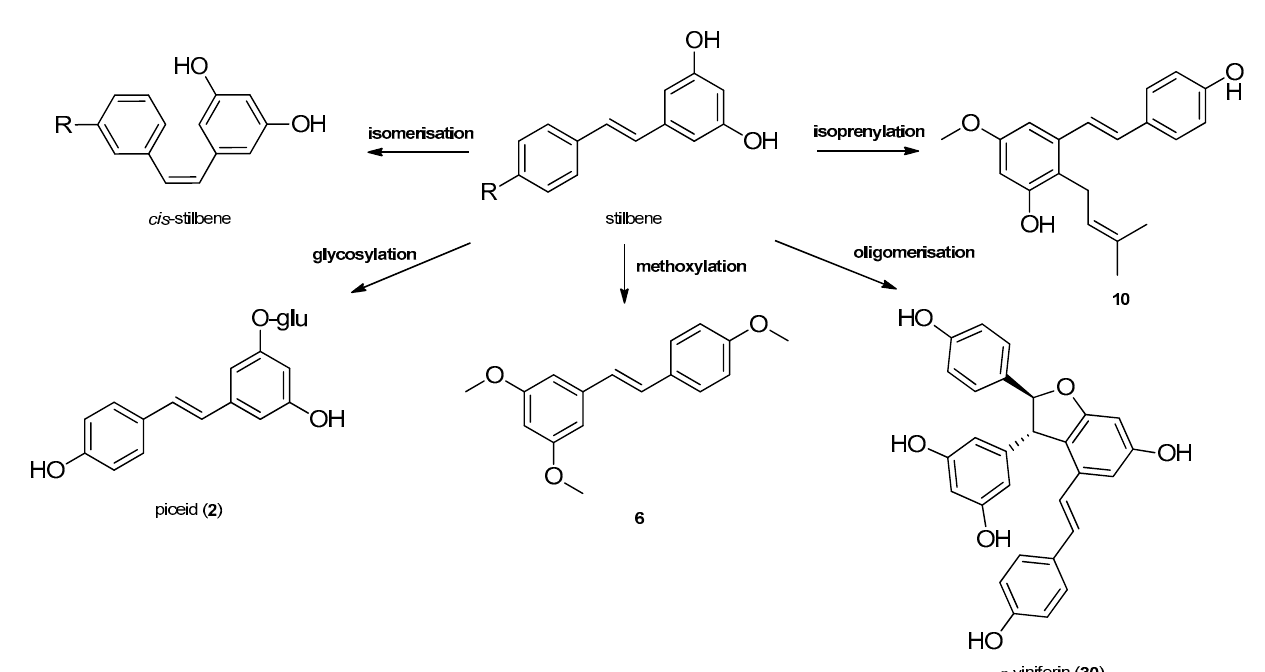
Figure 1. Biosynthesis of stilbenes .